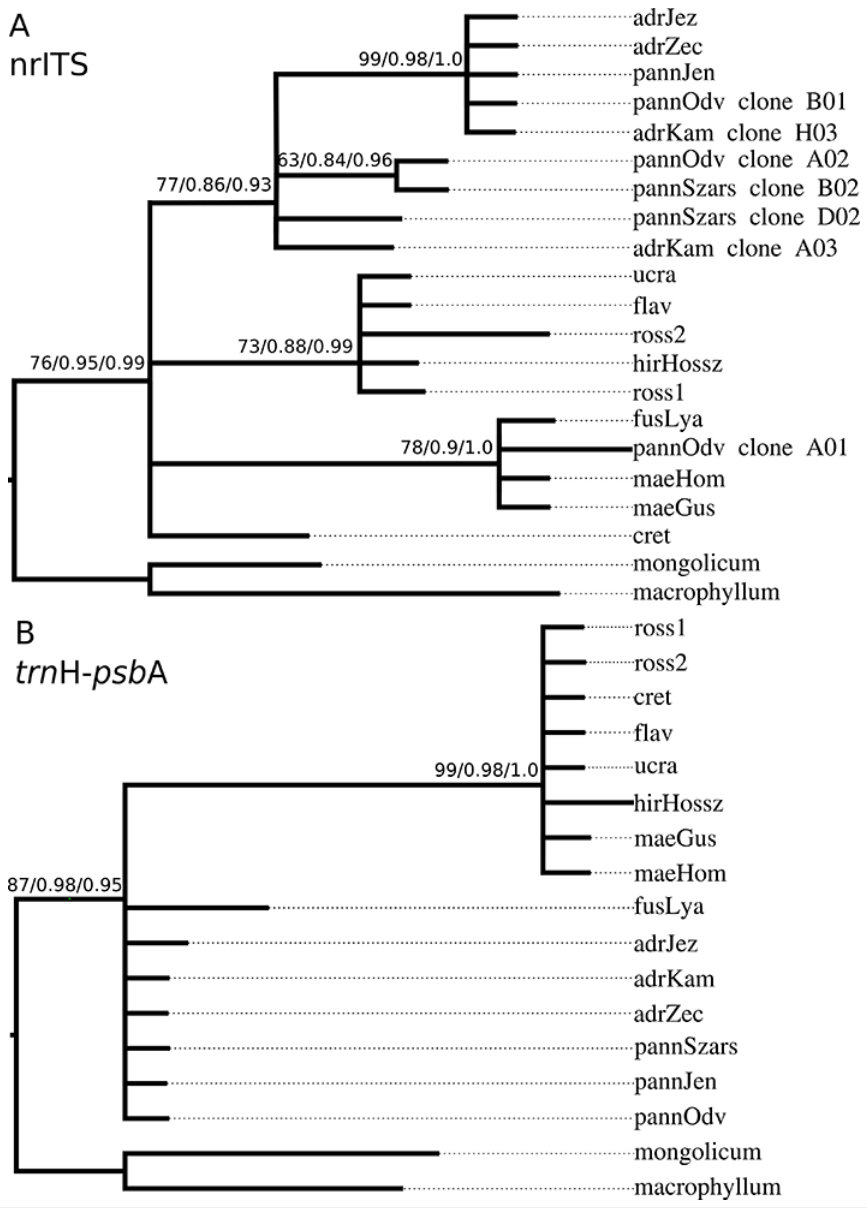
Figure 1 Phylogenetic relationships reconstructed using the nrITS sequences ( A ) and trn H- psb A sequences ( B ) presented on a phylogram. Support values on the branches refer to bootstrap support by MP/SH-aLRT probability calculated using phyML/Bayesian posterior probability as estimated by MrBayes. Identification codes used here refer to Table